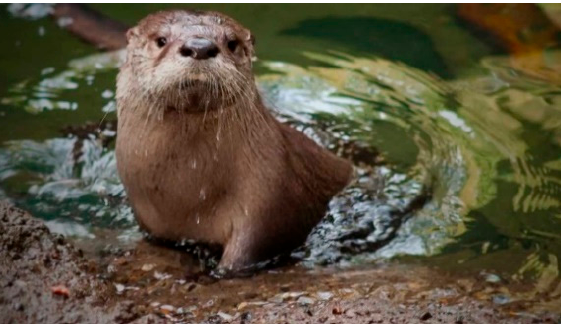
Figure 2. Muskrats could benefit from a new water control regimen. https://mymlsa.org/muskrats- in-the-lake-and-in-your-boat/ (accessed on 20 February 2021)